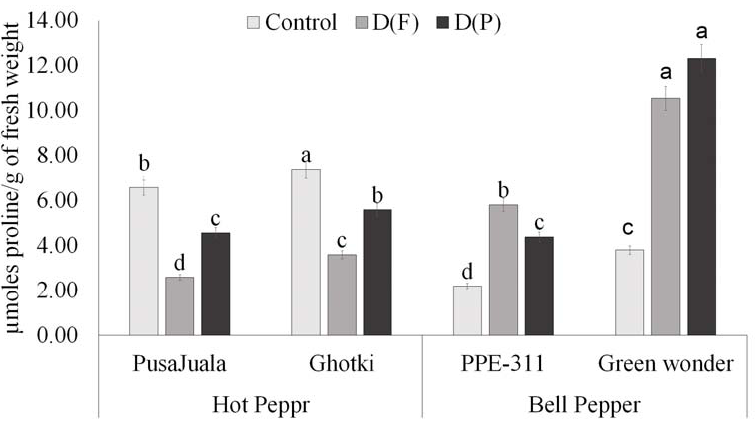
Figure 6. Proline contents of chili fruits. Means of three repetitions for each genotype with the same letters indicate the same means, and different letters indicate significant differences. Vertical bars represent standard error of means (bars = ± se) (LSD p < 0.05). DF = water stress at flowering stage, DP = water stress at the pod formation stage.